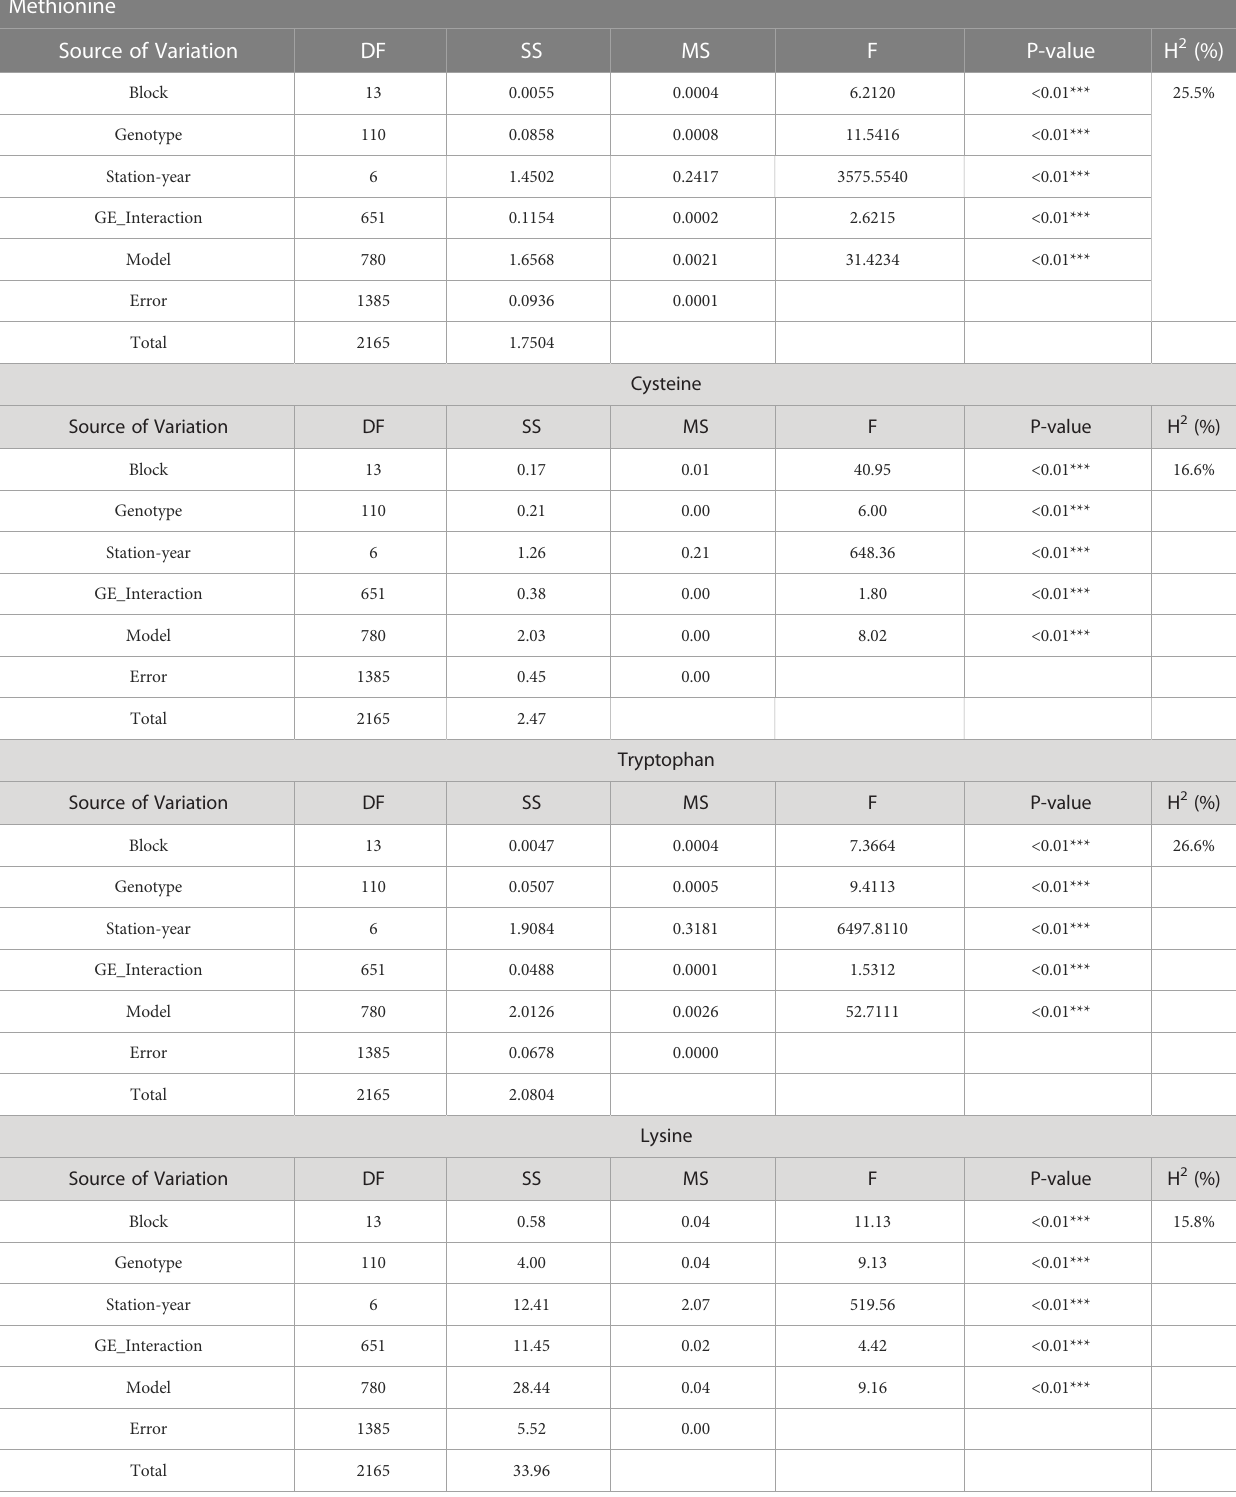
TABLE 4 ANOVA analysis on methionine, cysteine, tryptophan and lysine.